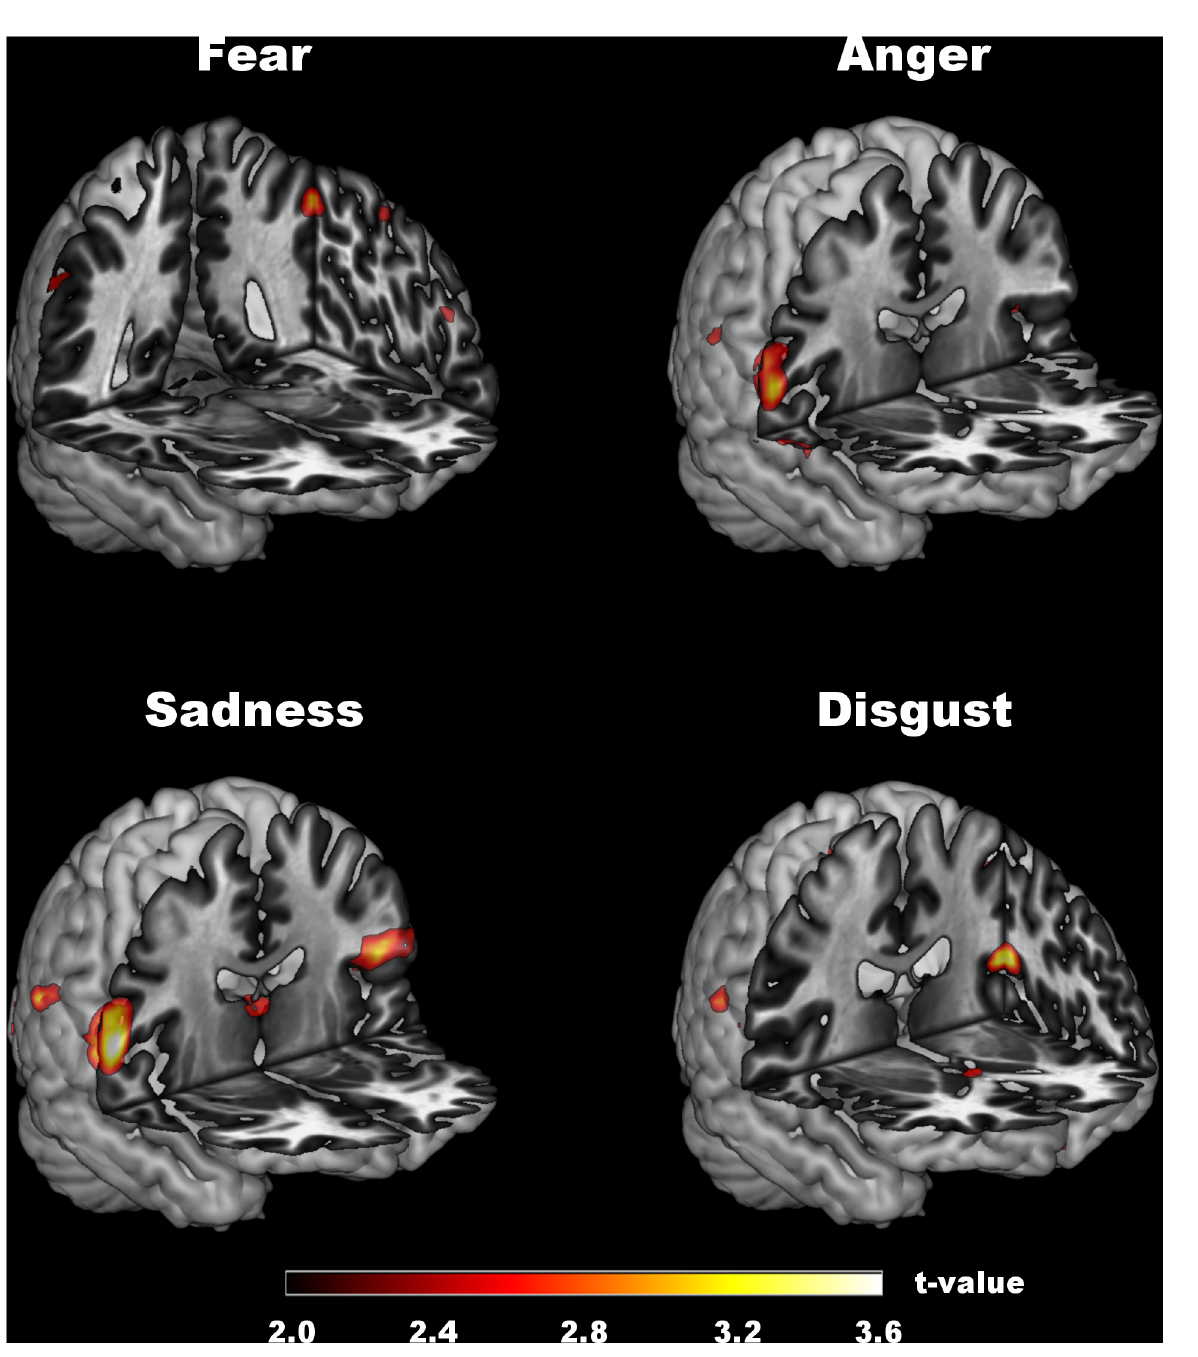
Fig 1. Regions with increased activation in patients compared to